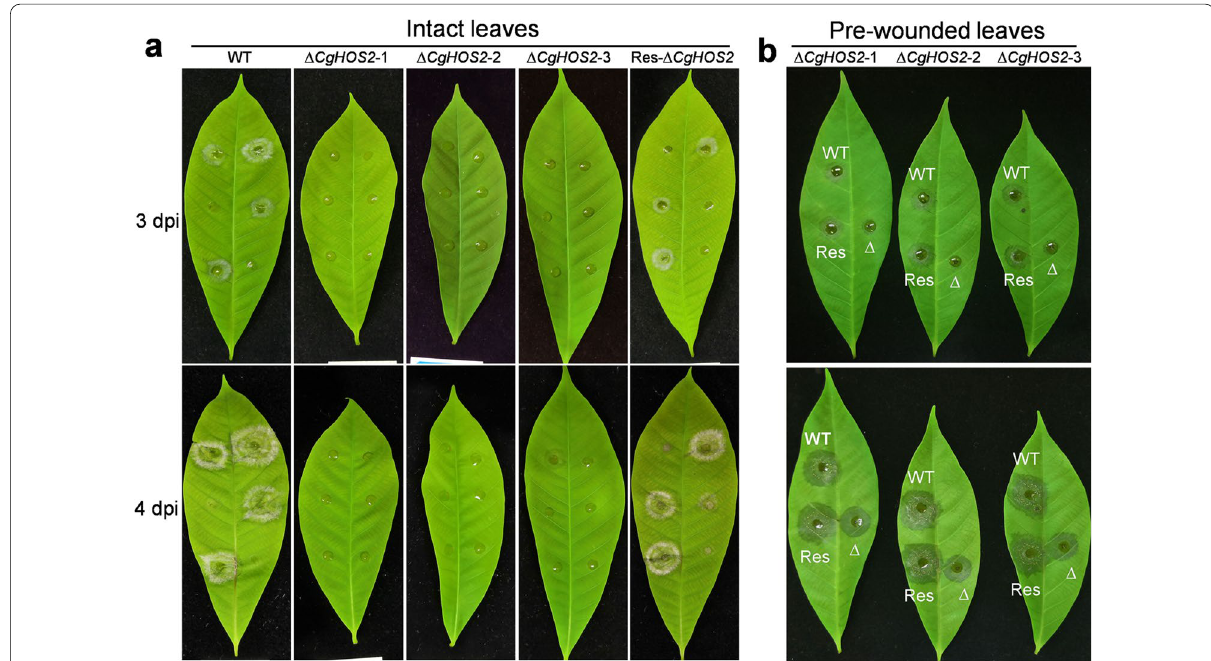
Fig. 5 CgHOS2 is required for the pathogenicity of C. gloeosporioides . a Symptoms on nonwounded rubber tree leaves at 3 and 4 dpi. b Symptoms on pre-wounded leaves at 3 and 4 dpi